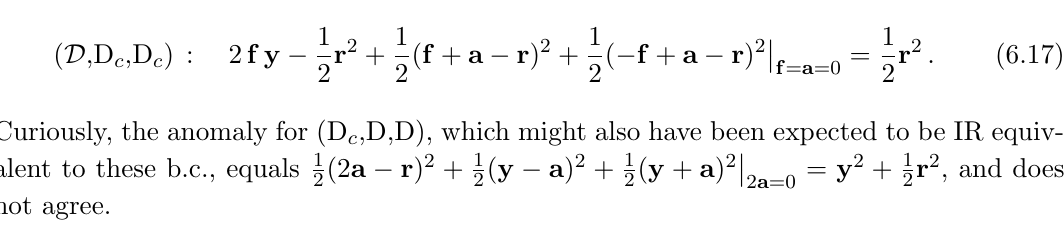
Table 1 . Elementary pairs of dual boundary conditions for SQED and XYZ. Additional boundary Fermi and chiral multiplets are denoted (cid:0) and C; ~ C , respectively, with their charge under U(1) gauge (or U(1) @ ), U(1) a and U(1) y encoded by fugacities s , a , and y in the subscripts. which agree. Moreover, these match the boundary anomaly of (